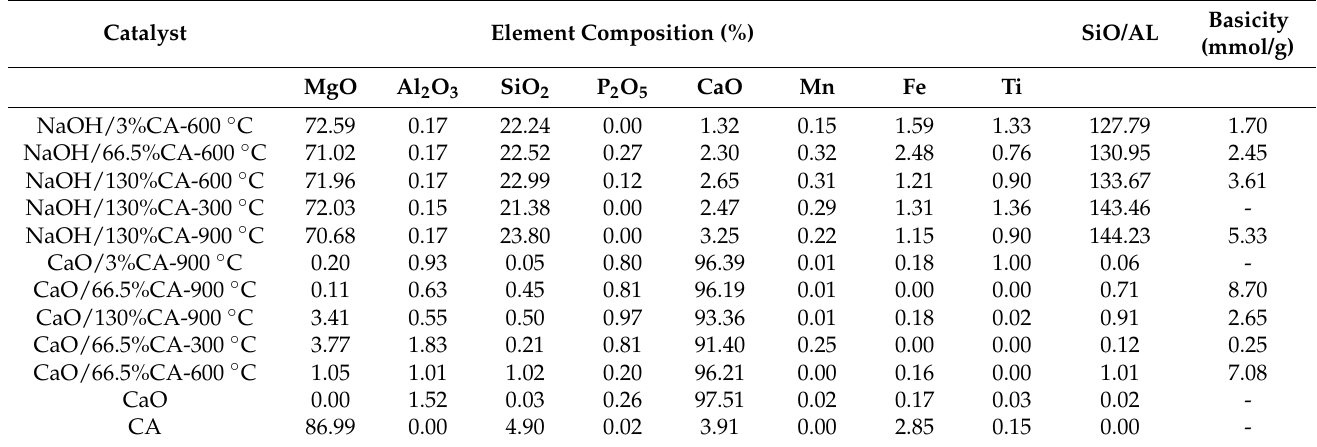
Table 1. Chemical composition of NaOH/130%CA and CaO/66.5%CA